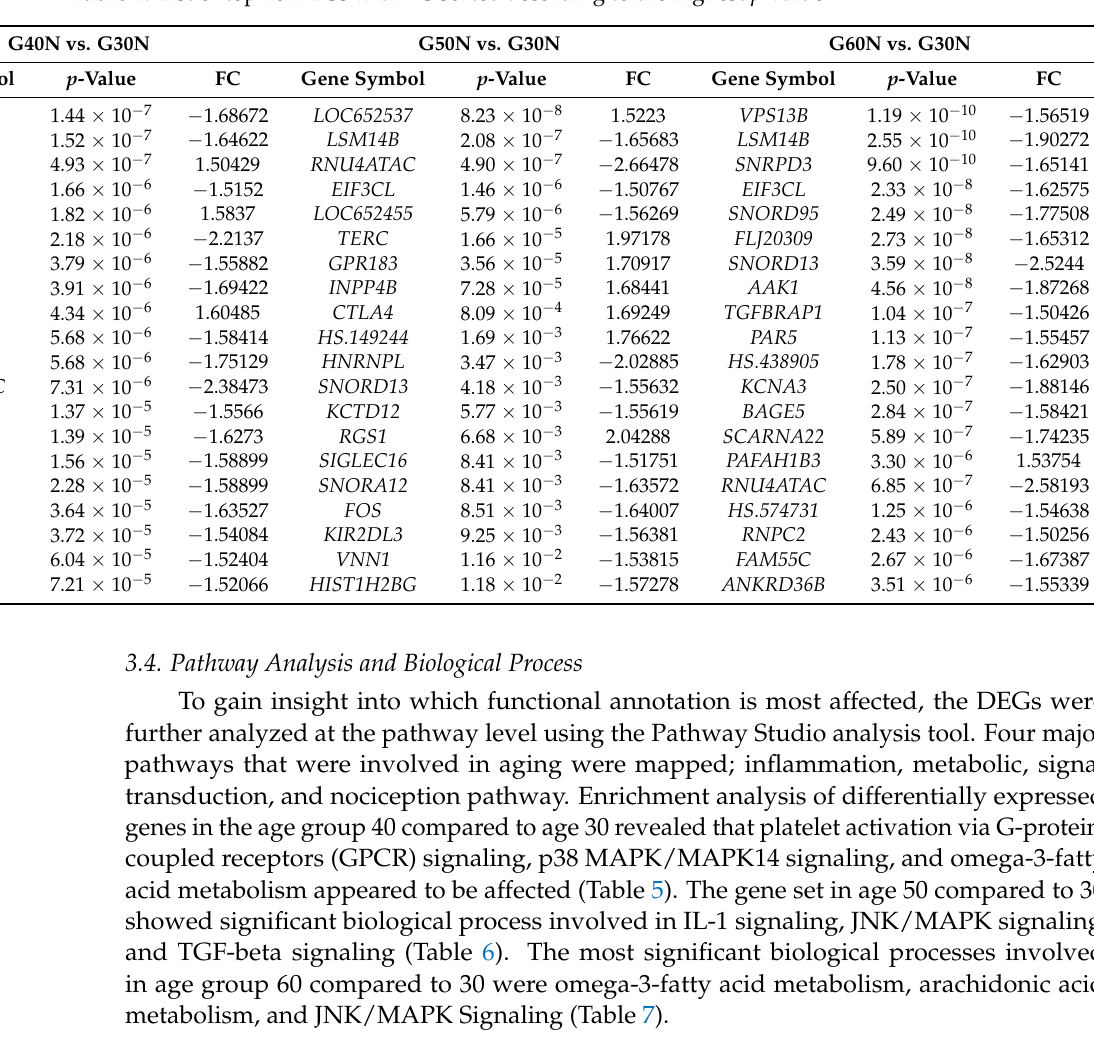
Table 4. List of top 20 DEGs with FC sorted according to the highest p